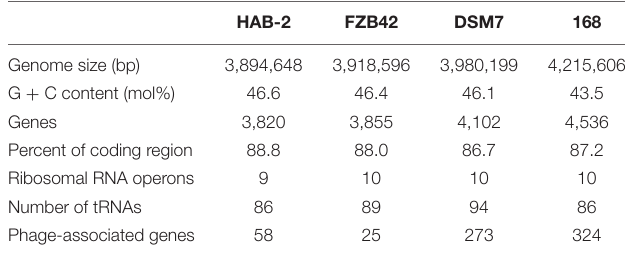
TABLE 1 | Genomic feature comparisons among B. velezensis HAB-2, B. velezensis FZB42, B. amyloliquefaciens DSM7, and B. subtilis